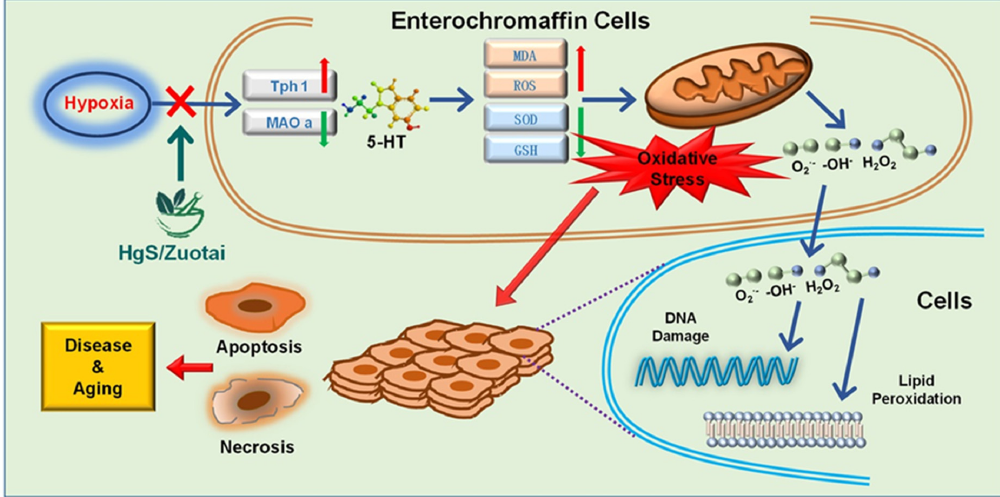
Figure 7. The proposed mechanism of HgS and Zuotai on hypoxia-induced oxidative stress.